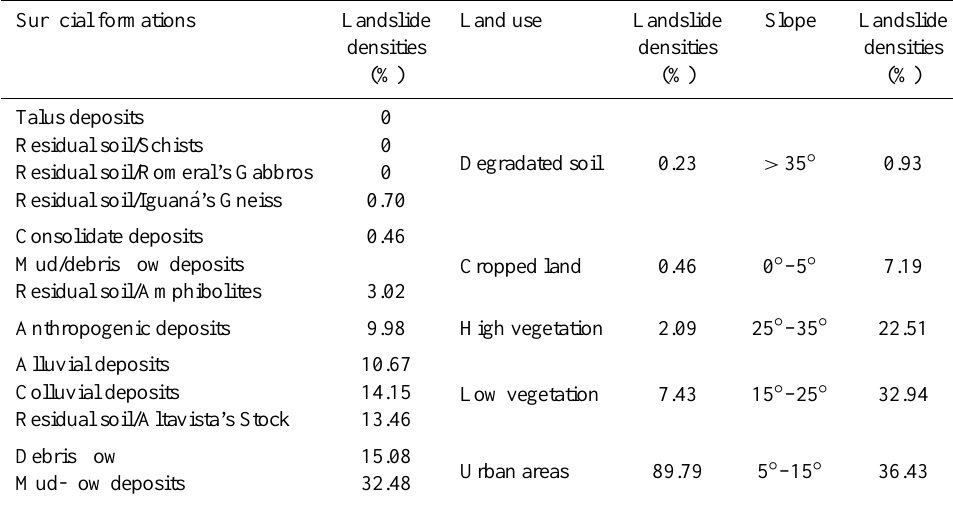
Table 3. Landslide densities used for the weighted susceptibility